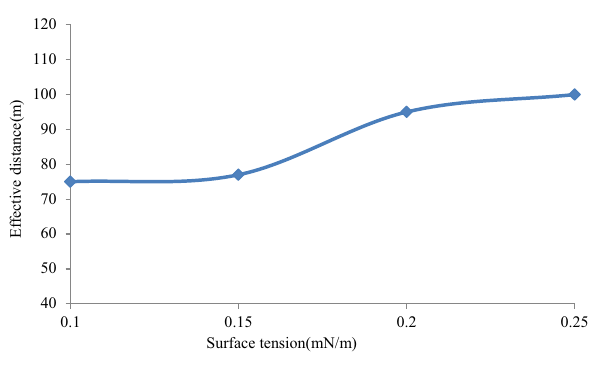
Fig. 12 Effective distances at different injection velocities